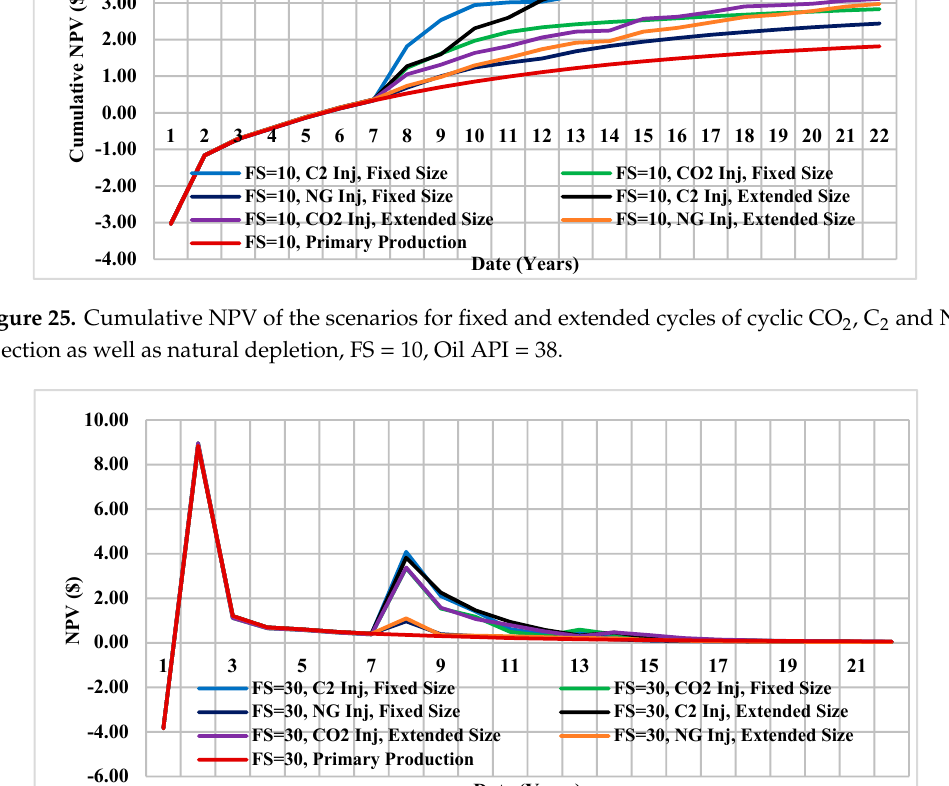
Figure 26. NPV of the scenarios for fixed and extended cycles of cyclic CO2, C2 and NG injection as well as natural depletion, FS=30, Oil API=31.